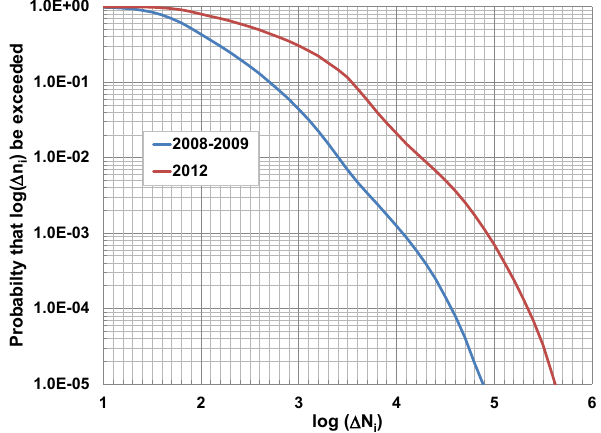
Figure 5. Complementary cumulative distribution functions of log( ∆ N i ) in the altitude interval [400 km, 800 km) for the years 2008-2009 (blue) and 2012 (red).